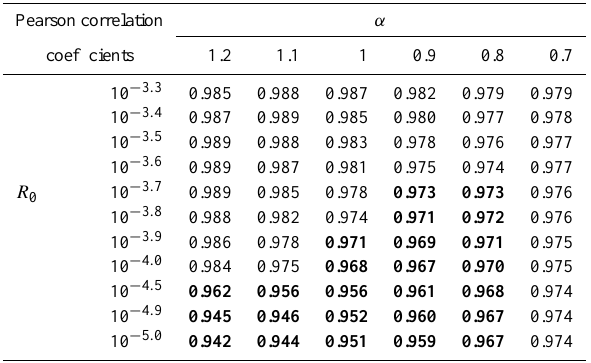
Table 6. RMSD values among X trend and X theor values obtained for the case of 5 September 2012. Bold values are greater than the obtained mean